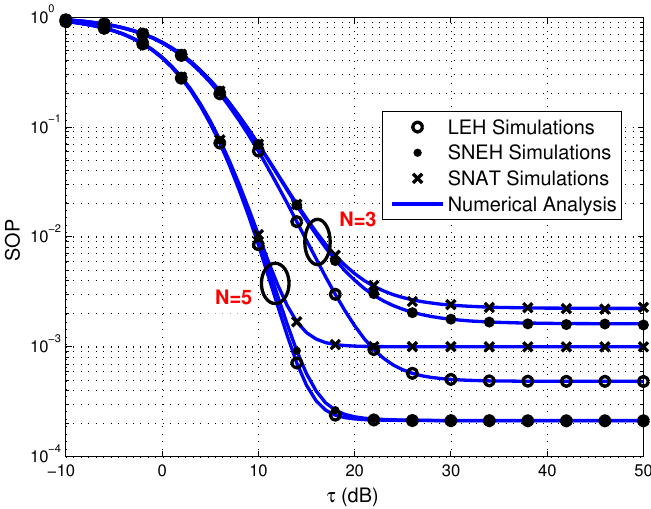
Figure 3. Secrecy outage probability versus τ for three EH modes under various N , where N = { 3,5 } .